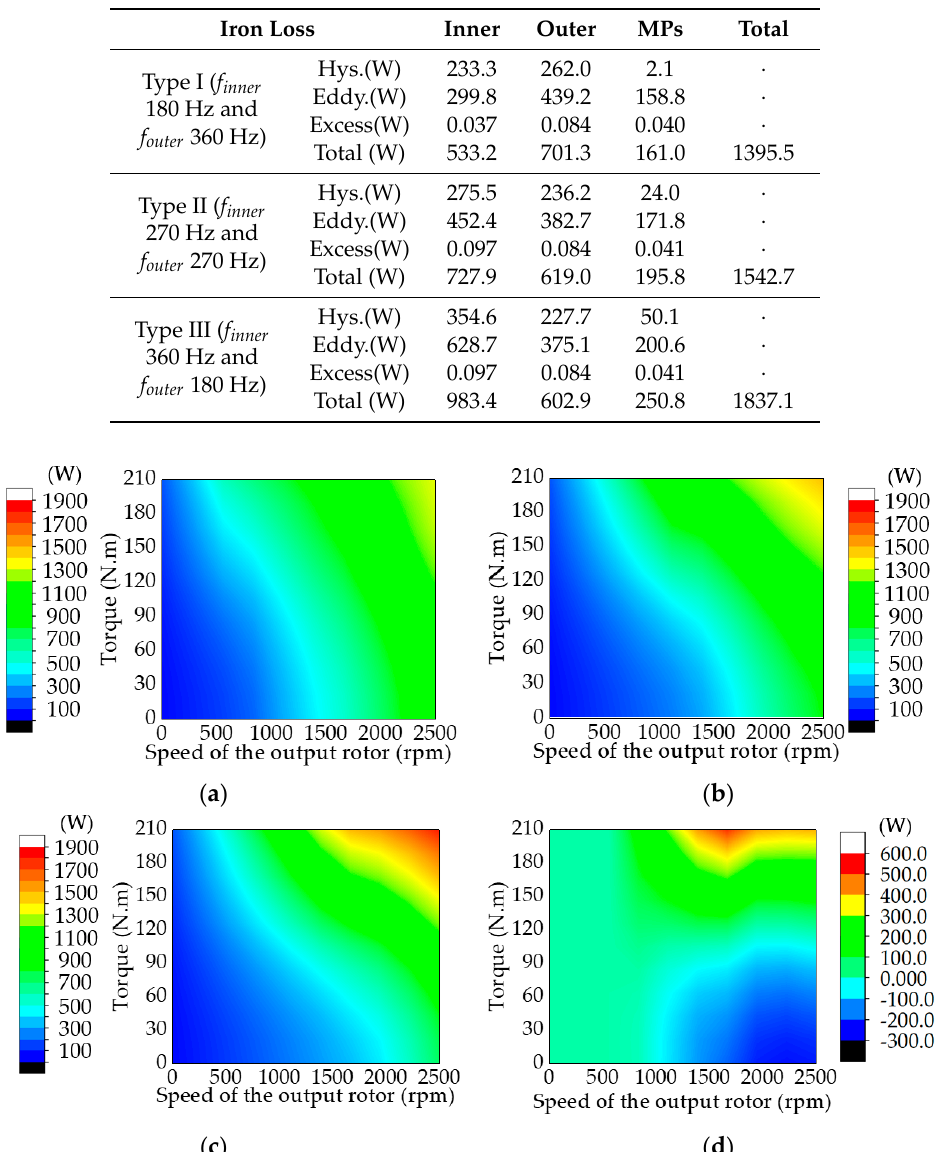
Table 2. Iron loss according to the frequency conditions (@2492 rpm and 210 Nm).